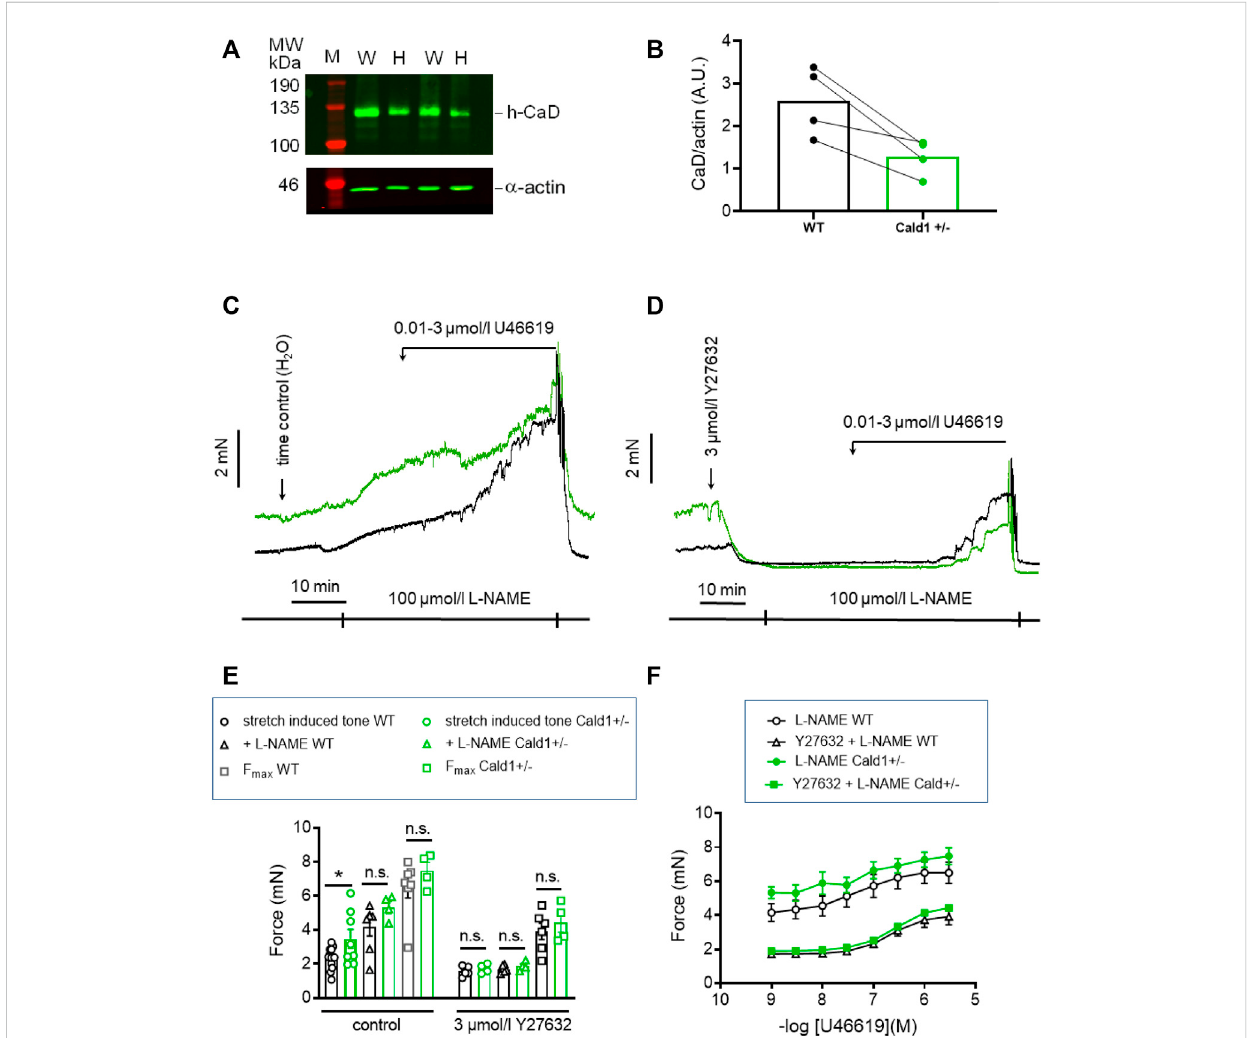
Effect of Caldesmon targeting on tone maintenance in basilar arteries from old mice. (A) Representative Western blot of expression of h-CaD in WT andheterozygouss-BAsfrom2litters (B) statistical evaluationfromarteriesoffour independent measurements( n =3litterswithWT andHet littermates, n = 1 WT and Het from different litters). M, marker; W, wilde type; H, heterozygotes. Caldesmon expression the Ponceau Red stained actin band. (B) Statistic evaluation. (C,D) Original force tracings representing the effect of caldesmon mutation on tone. (E) Statistic evaluation of